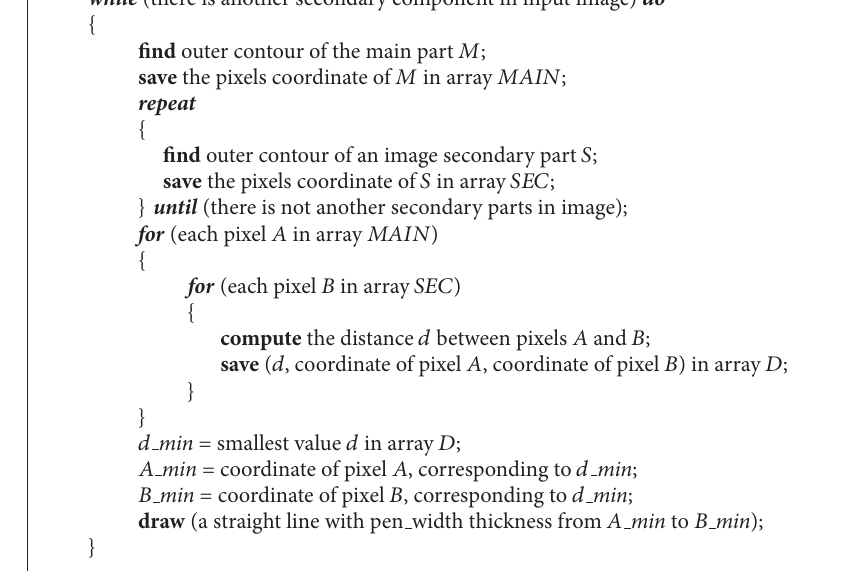
Algorithm 1: The proposed procedure to connect the broken image segments.